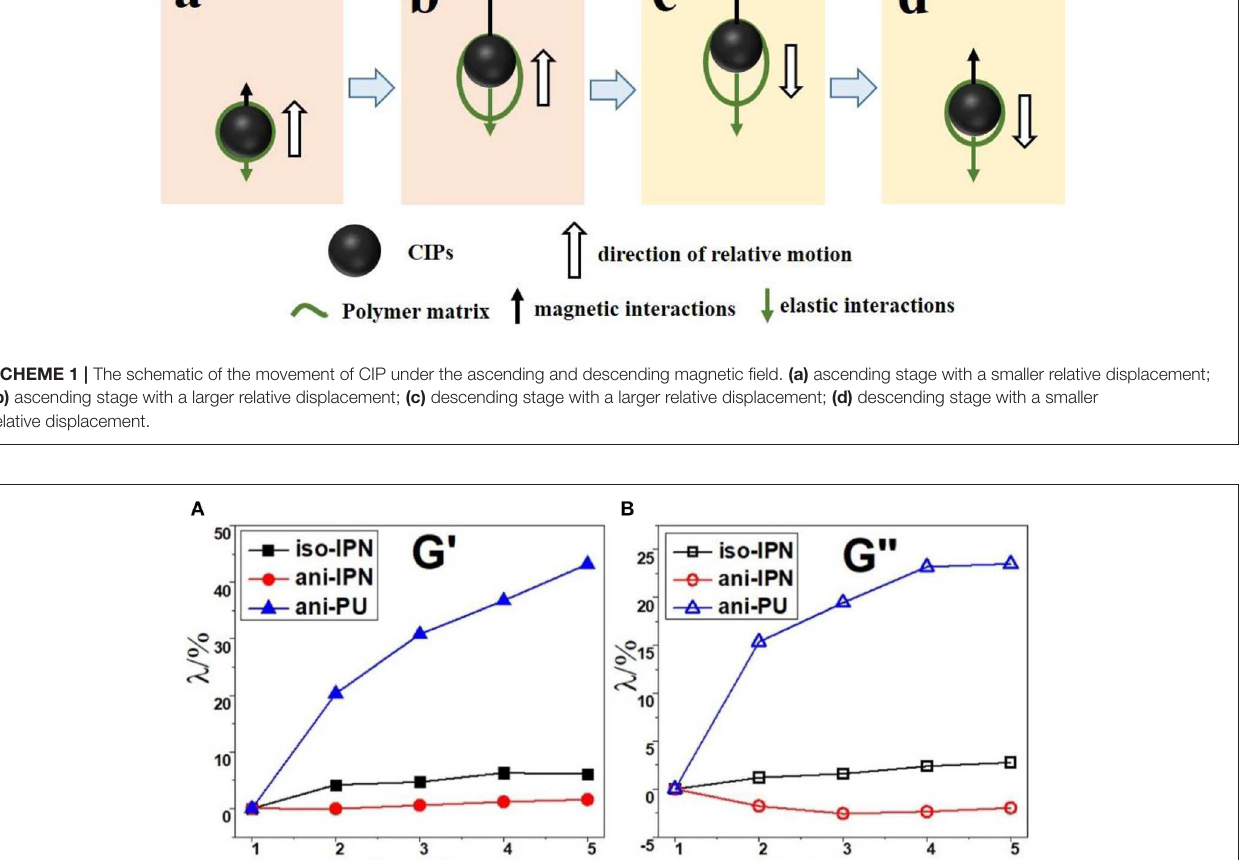
Amplitude Cycling